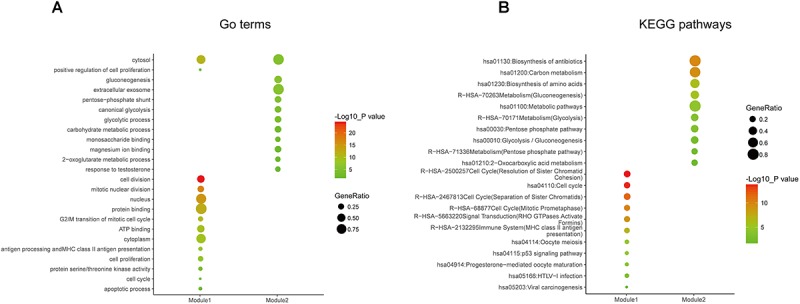
Gene ontology and pathway enrichment analyses of the modules in the PPI network. (A) GO enrichment analysis of module 1. The y-axis labels represent clustered GO terms. The GeneRatio represents the ratio of the number of genes enriched in one GO term to the number of genes in module 1. (B) KEGG pathway enrichment analysis of module 2. The y-axis labels represent clustered KEGG pathways. The GeneRatio represents the ratio of the number of genes enriched in one KEGG pathway to the number of genes in module 2. GO, gene ontology; KEGG, Kyoto Encyclopedia of Genes and Genomes; PPI, protein–protein interaction.